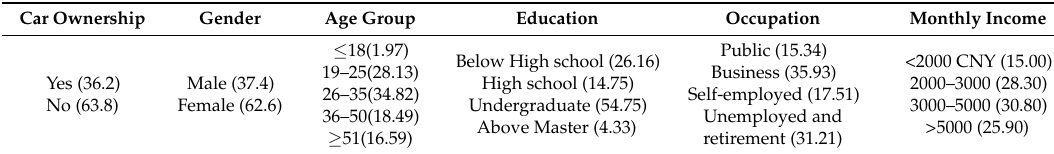
Table 1. Socio-economic characteristics of respondents